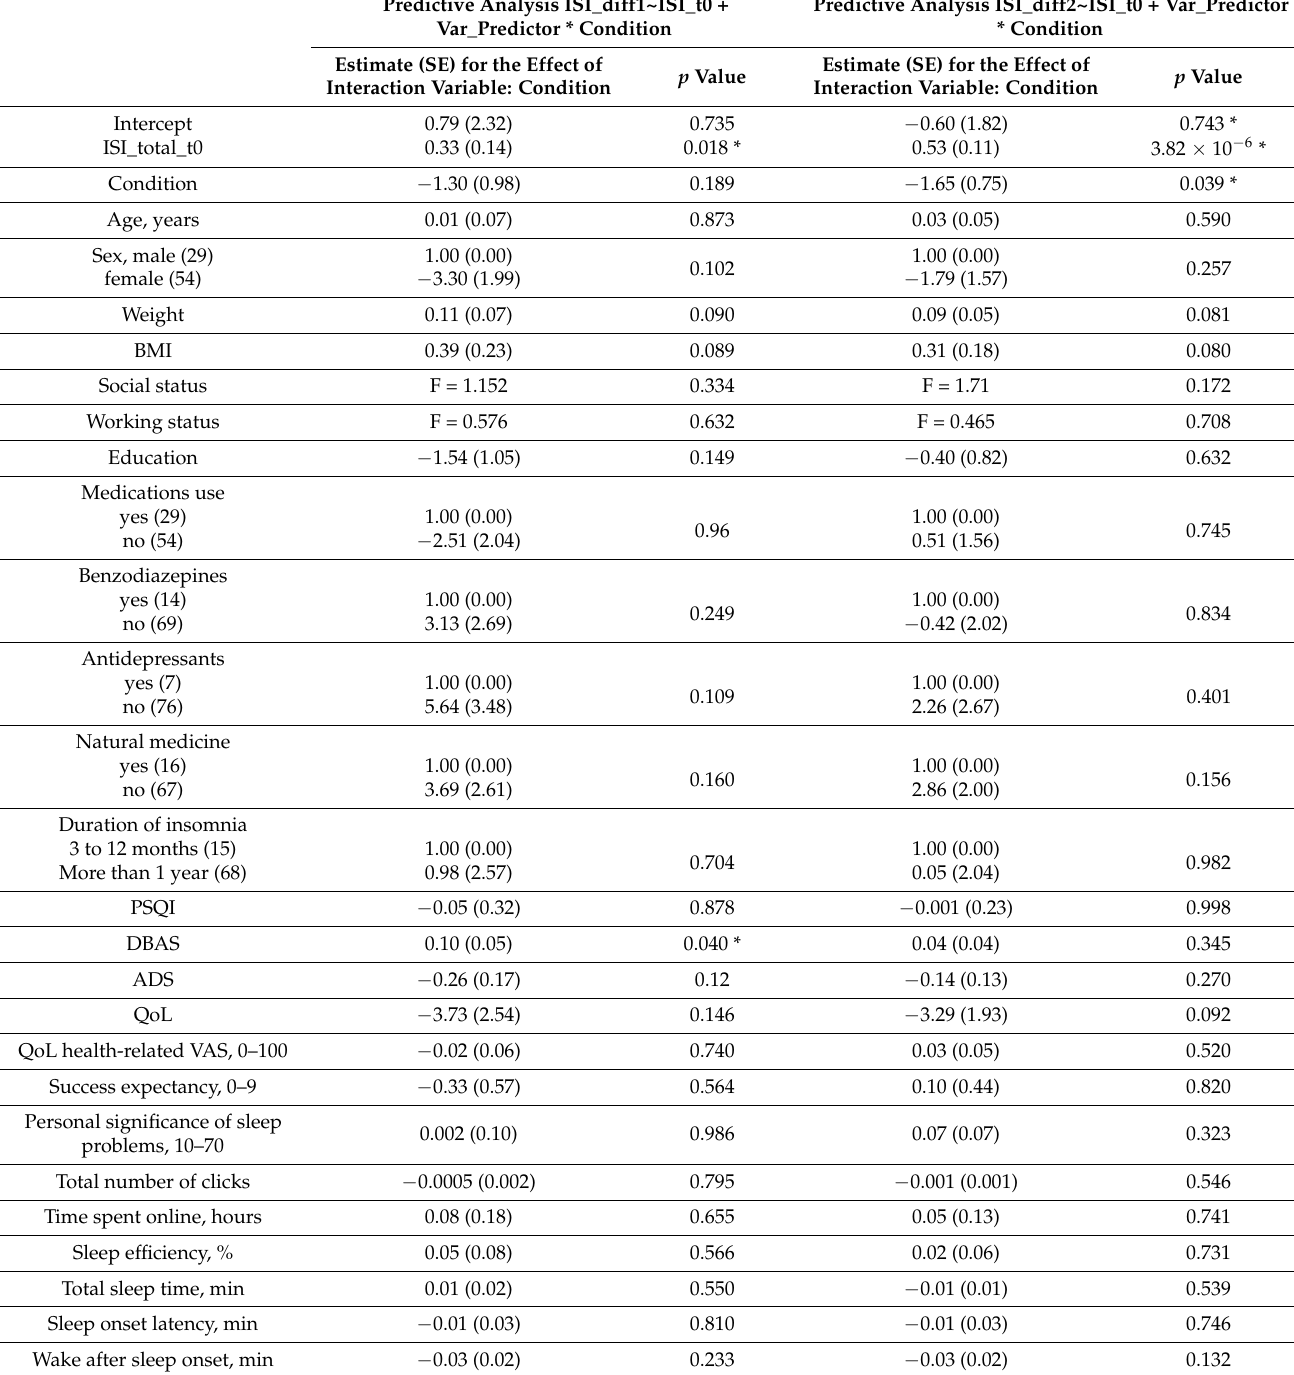
Table 3. Predictive regression analysis coefficients. A p -value indicates a significance of relationship between the baseline variable and ISI improvement post-treatment. The greater ISI improvement reflecting improvement after treatment is characterized by the higher estimate. In the prognostic analysis columns estimates, standard errors, and p -values are presented for the effect of interaction predictor * condition.